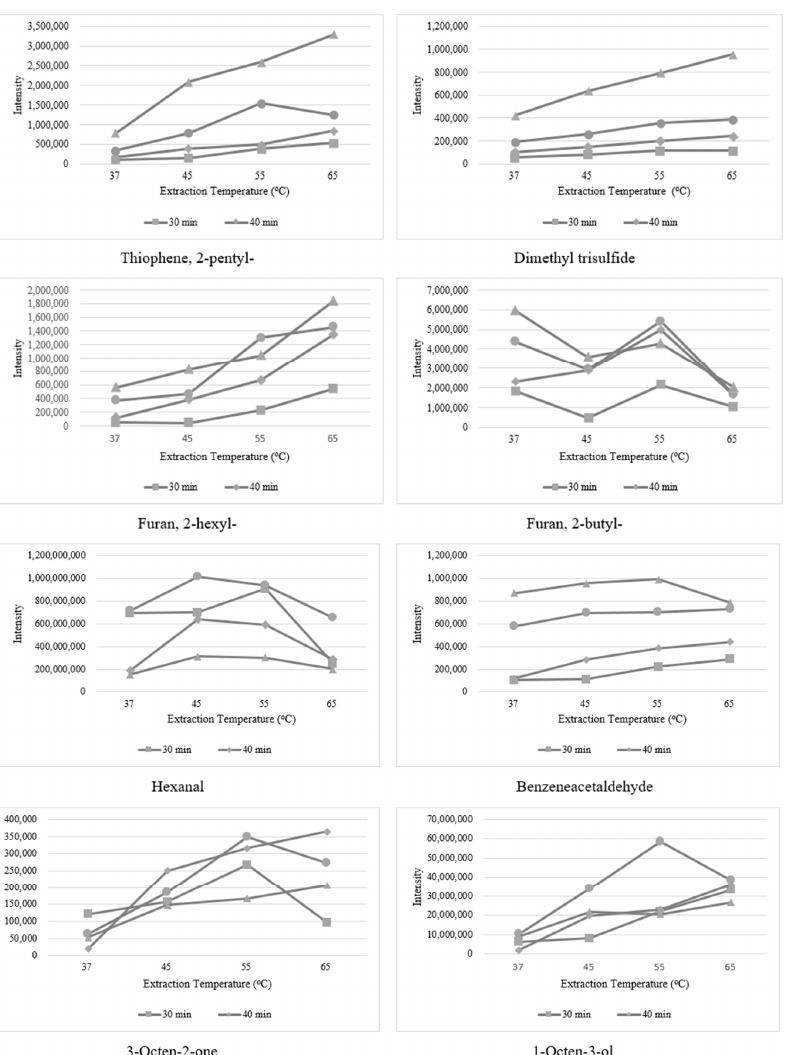
Figure 2. The influences of the extraction temperature and the extraction time on the intensities of some typical volatiles. As shown in Figure 3, with the increase in the desorbing time, the signal intensities for most of the compounds were steadily increased at the beginning. However, the inten- sities for some of the compounds were decreased when the desorbing was further pro- ceeding. Therefore, the SPME conditions of incubation at 55 °C for 10 min, extraction at 55 °C for 50 min, desorbing at 270 °C for 3 min would be considered as the optimum.